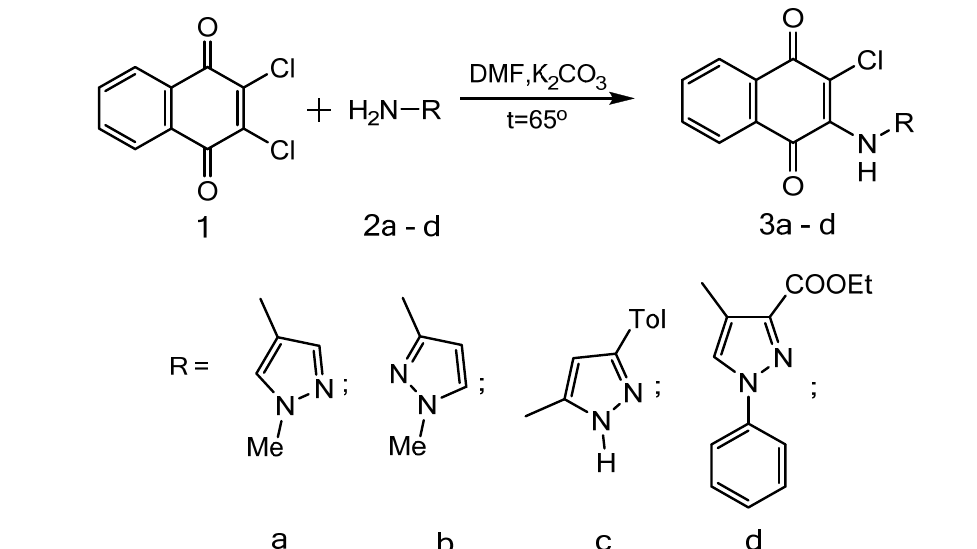
Fig. 1. Synthesis scheme of heterocyclic amino derivatives of